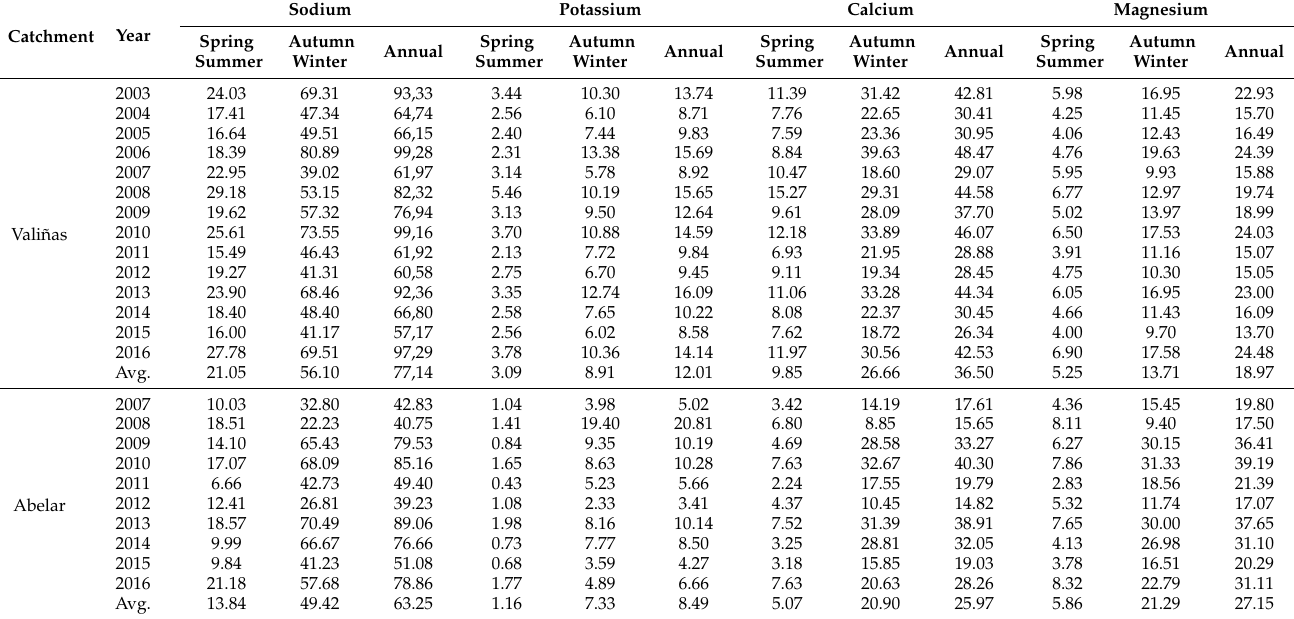
Table 4. Macronutrient loads (kg ha − 1 ) for the spring-summer and autumn-winter periods, as well as the annual load, of the studied years in both Valiñas and Abelar catchments. Avg. = average. Catchment